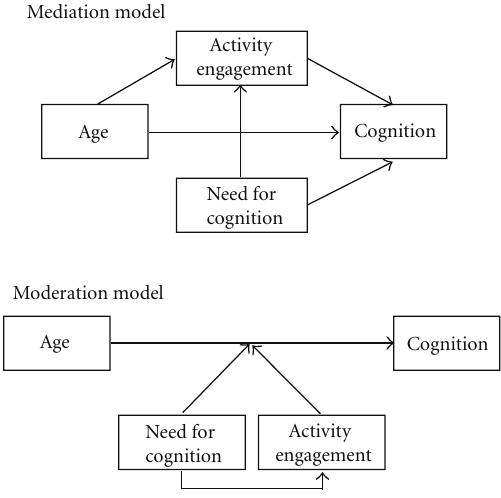
Figure 1: Mediation and moderation